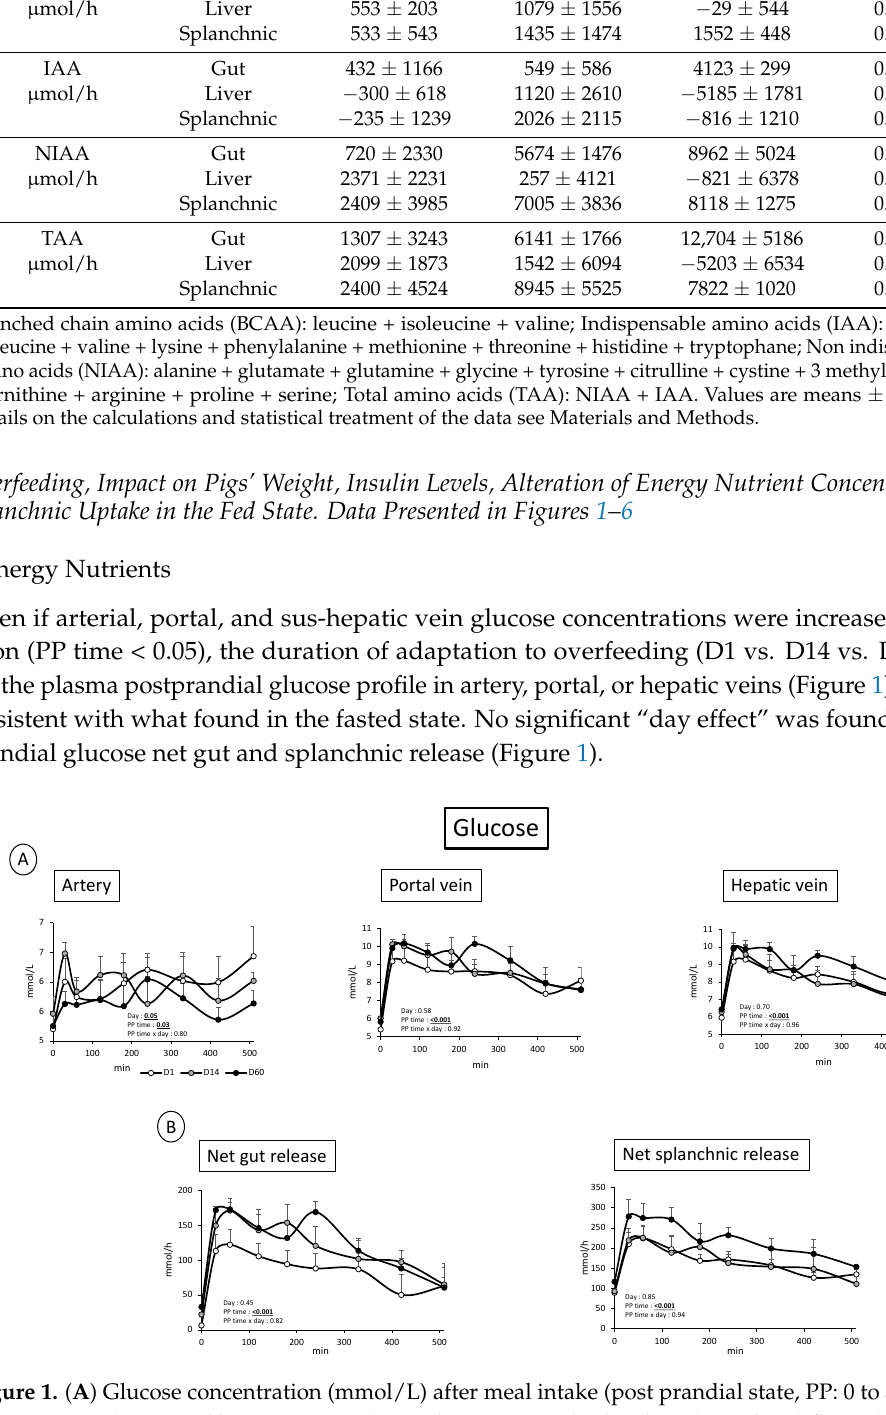
Figure 1. ( A ) Glucose concentration (mmol/L) after meal intake (post prandial state, PP: 0 to 510 min) in artery, portal vein, and hepatic vein. ( B ) Net glucose gut and splanchnic (gut + liver) fluxes (mmol/h) after meal intake (Post prandial state, PP: 0 to 510 min) before (D1) and after 14 days (D14) and 60 days (D60) of adaptation to HFHS diet. Two-way RM ANOVA, * D14 significantly different from D1, † D60 significantly different from D1, ‡ D60 significantly different from D14; Values are means ± SEM. For calculations and statistical treatment of the data and for details, see Materials and